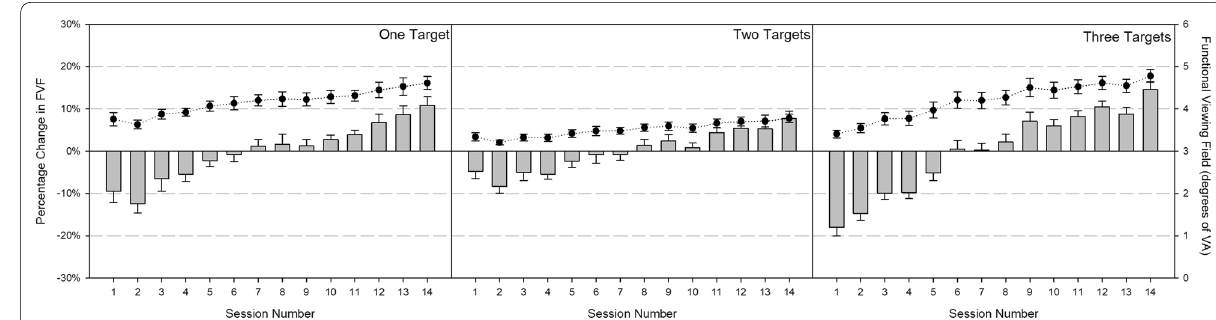
Fig. 9 Functional viewing field (circles) and percent change in functional viewing (bars) across sessions for one- (left graph), two- (middle graph), and three-target (right graph) trials. Error bars reflect 1 standard error ±